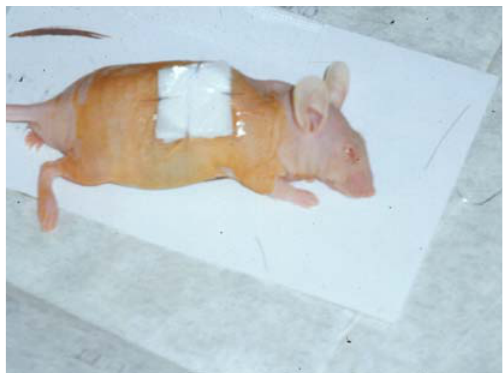
FIGURE 3 – Suture of two stacked pieces of Telfa ® or rayon with triple antibiotic ointment over the cultured composite skin